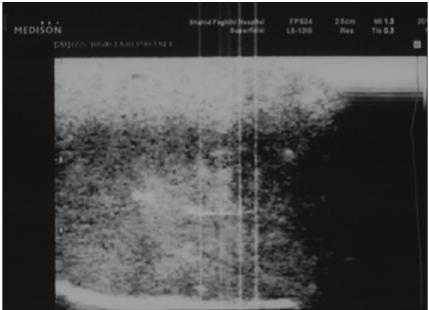
Figure 1: Left axillary ultrasound shows a well-defined mass with area of punctuate calcification.